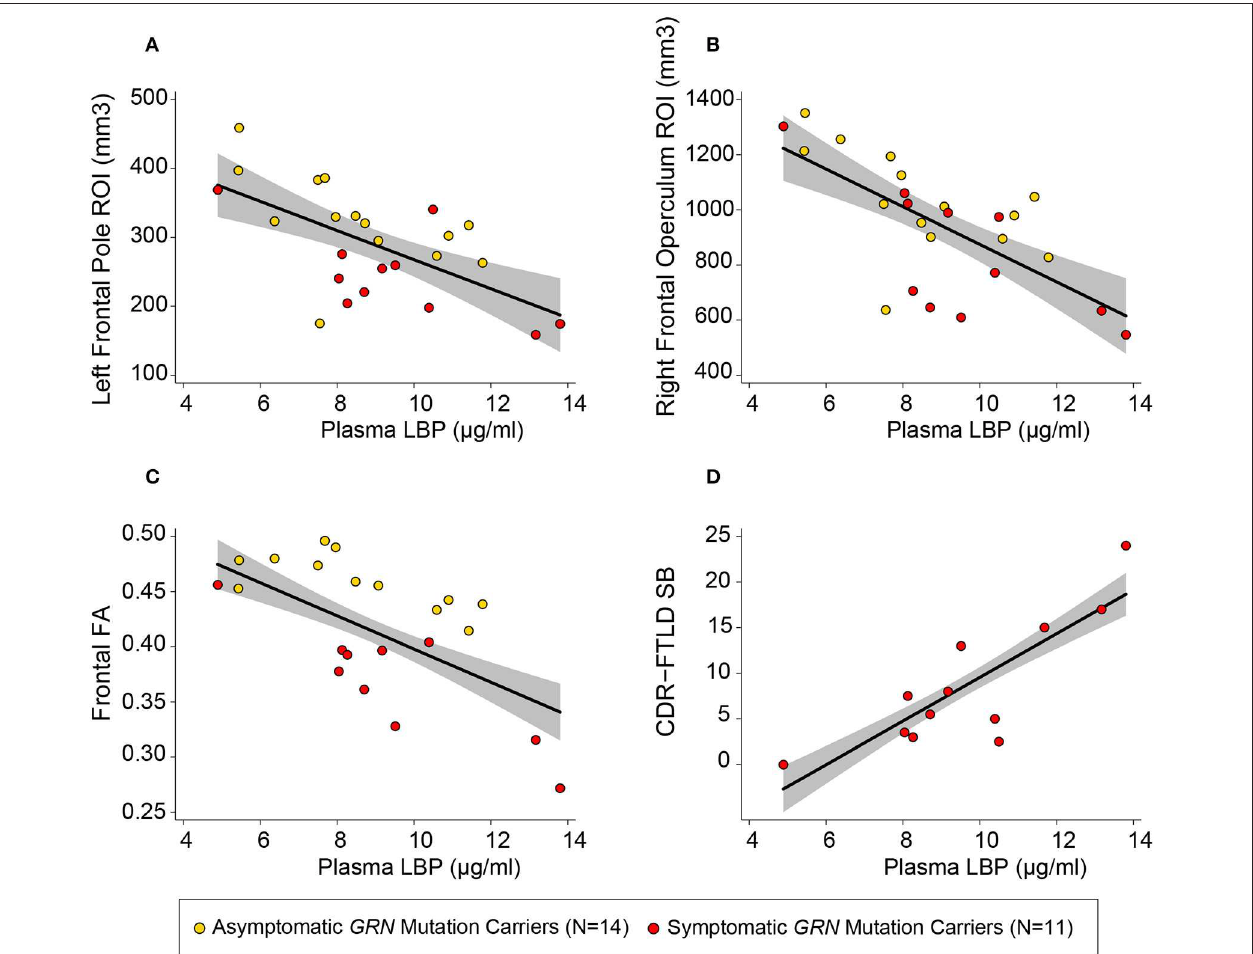
FIGURE 3 | Plasma LBP correlates with white matter integrity and clinical severity. Circles represent uncorrected plotted values for individual GRN mutation carriers within our study, with yellow circles representing asymptomatic individuals and red circles representing symptomatic individuals. The left frontal (A) and right frontal (B) regions of interest (ROIs) depicted were defined by the left frontal pole white matter and right inferior frontal operculum white mater clusters described in Table 2 . A linear regression line [controlling for age and sex, as well as total intracranial volume (TIV) for models with volumetric measures] with a gray 95% confidence interval has been superimposed on each plot [ (A) R 2 = 0.85, p = 0.024 uncorrected; (B) R 2 = 0.86, p < 0.0005 uncorrected; (C) R 2 = 0.59, p = 0.009; (D) R 2 = 0.75, p = 0.003